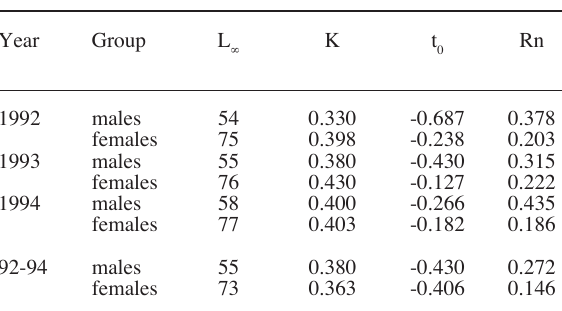
T ABLE 3. – Results of the growth parameters (size-age relationship) for the VBGF model obtained using the FISAT (ELEFAN) pro- gramme, for males and females of Aristeus antennatus, with t of 23.05 mm in males and 29.18 mm in D females.